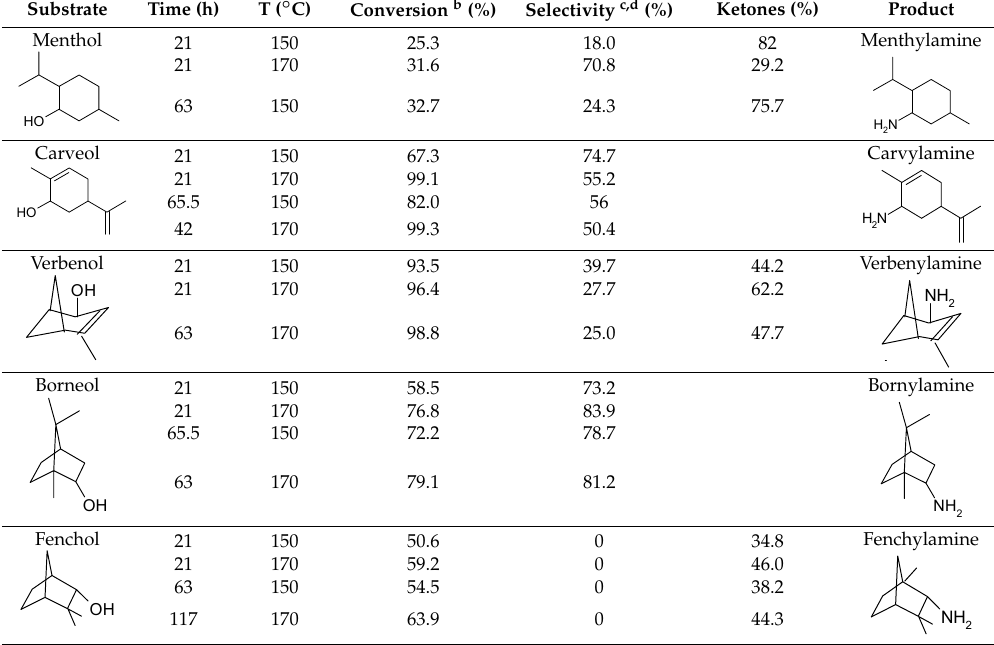
Table 4. Secondary terpene alcohol amination with [Ru 3 (CO) 12 ]/L9 a . Adapted from [125].